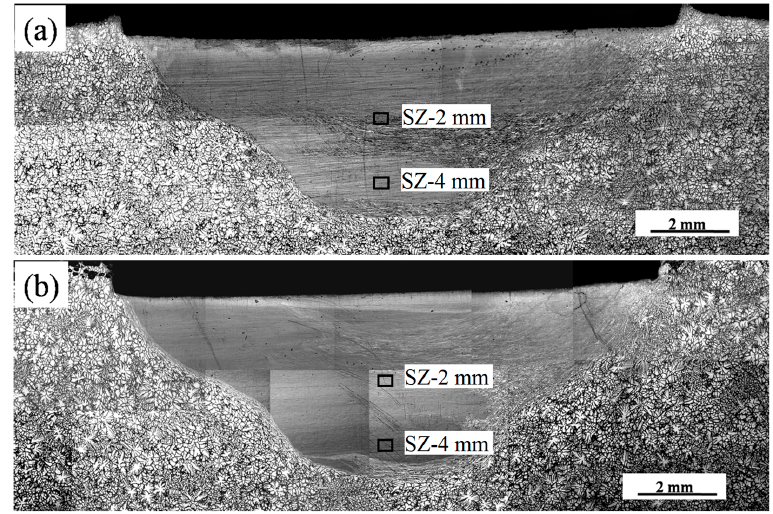
Figure 3. Low-magnification optical macrographs of FSP Mg-6Sn samples (TD-ND plane): ( a ) FSP1 and ( b )